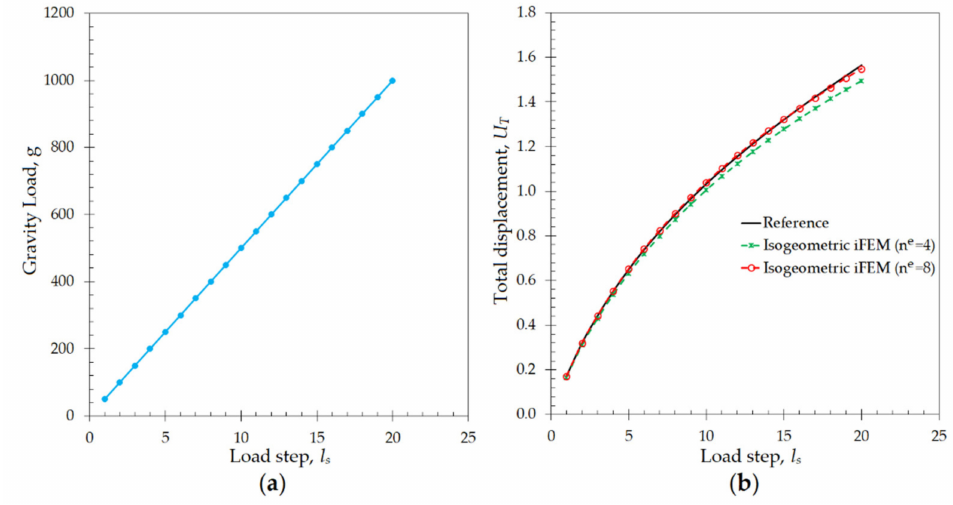
Figure 8. ( a ) Variation of gravity load and ( b ) maximum U T displacements [m] versus increasing number load steps for Scordelis–Lo